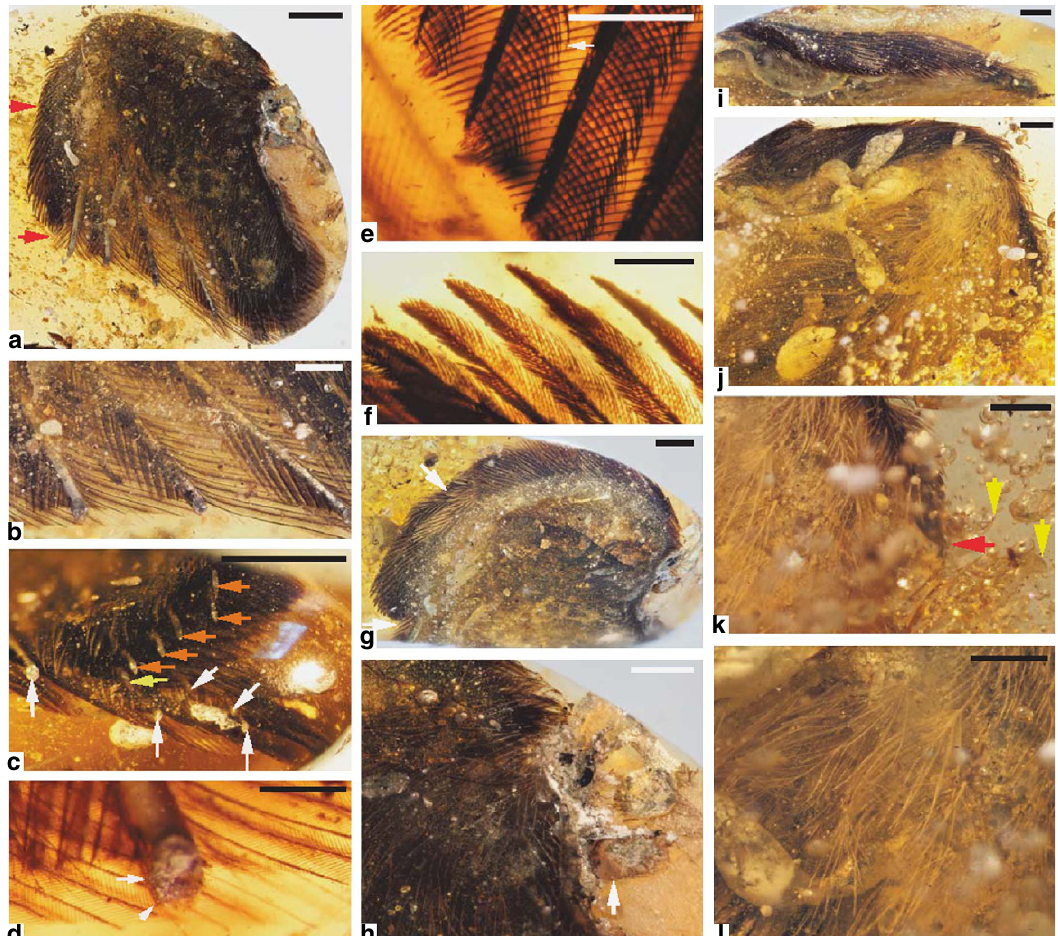
Figure 2 | DIP-V-15100 photomicrographs. ( a ) Overview of dorsal wing surface, with claws (red arrows), dorsal details in a – h . ( b ) Primary feathers and barbs truncated by amber surface. ( c ) Primaries (white arrows), secondaries (yellow arrows) and indeterminate feather (orange arrow), in basal zone of overlap (slightly oblique view). ( d ) Detail of primary rachis, with weak ventral ridge (inclined arrow) and barb ramus attachment somewhat low on side of rachis (horizontal arrow). ( e ) Primary feather microstructure and pigment distribution (t.l.), with hooklets on distal barbules (arrow). ( f ) Alula barbs with blunted apices and blade-like barbules with banded pigmentation. ( g ) Anterodorsal view highlighting alula separation from wing surface (arrows), as well as overall colour patterning (light hitting bubbles in amber creates a bright band paralleling edge of wing). ( h ) Bone and integument breaching amber surface, with well-preserved osteon complexes (circle of mottled bone at arrow), while most voids in bone and tissue have been permeated by milky amber, and skin is reduced to a translucent film not visible at this scale. ( i ) Extent of gas vacuoles and milky amber emanating from dorsal and ventral surfaces of wing, in anterior view. ( j ) Contrast between coverts and ventral coat of down and contours, with ventral details in j – l . ( k ) Current position of claw (red arrow) and claw marks within flow lines (yellow arrows). ( l ) Bases of down feathers attached to apterium with preserved skin texture and signs of saponification. Scale bars, 2.5mm ( a , c ); 1mm ( b , h – l ); 0.5mm ( d ); 0.25mm ( e , f ); 1.5mm ( g ); t.l., transmitted